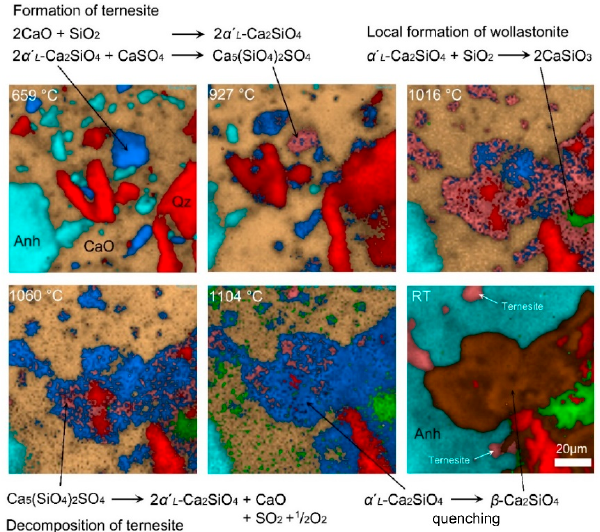
Figure 7. Selected reaction steps of CaO + SiO 2 + CaSO 4 observed by in situ Raman microspectroscopic imaging during heating and quenching (figure adapted from [9]; see reference for details). RT, room